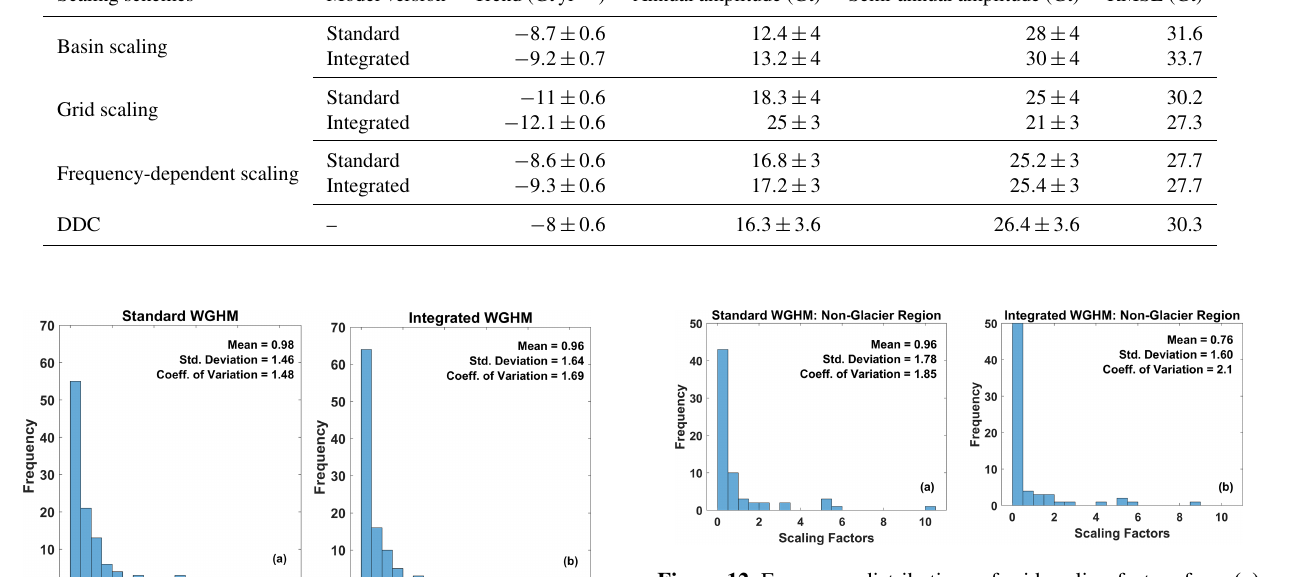
Figure 12. Frequency distributions of grid scaling factors from (a) standard and (b) integrated WGHM versions for the non-glaciated region of the Indus Basin. Notice the increased frequency of scaling factors < 0 . 5 in the Integrated